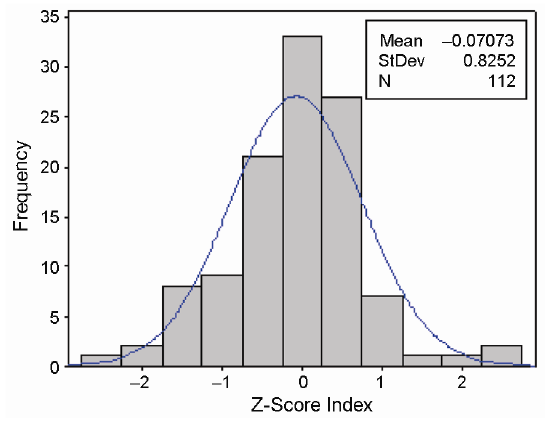
Fig. 4. The histogram of the PEPM Homogeneity